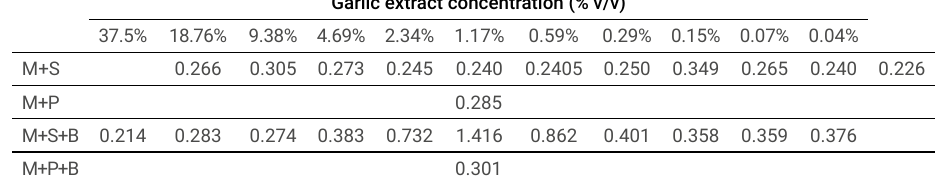
Table 1. Results of the Minimum Inhibitory Concentration (MIC). M = media S = samples (garlic extract) P = solvent B = bacteria (Streptococcus